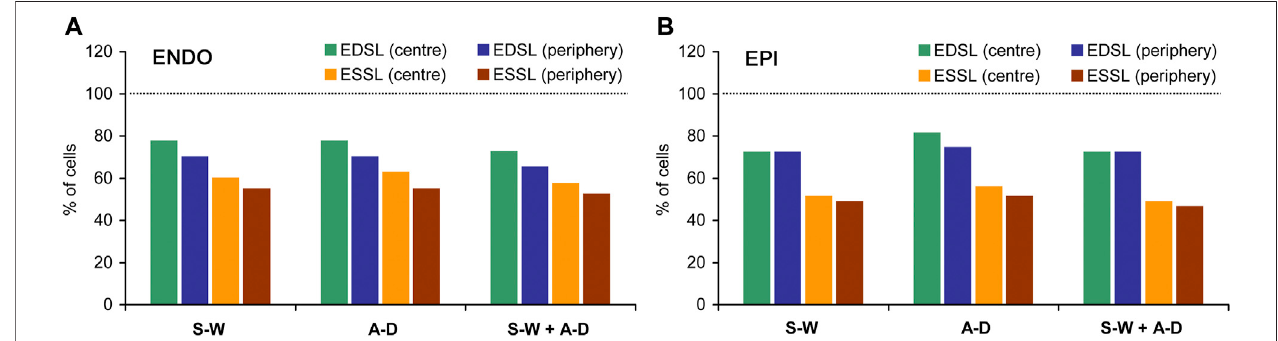
FIGURE 3 | The percentage of ENDO (A) and EPI (B) cardiomyocytes in which distributions of individual end-diastolic SL (EDSL) and end-systolic (ESSL) passed different normality tests. S-W: Shapiro-Wilk one-sample test, A-D: Anderson-Darling one-sample test; S-W + A-D: Shapiro-Wilk one-sample test together with Anderson-Darling one-sample test (both tests passed). The number of ENDO cardiomyocytes n = 40, the number of EPI cardiomyocytes n = 43 (from 8 hearts). Dotted horizontal lines correspond to the level where all cells passed a test